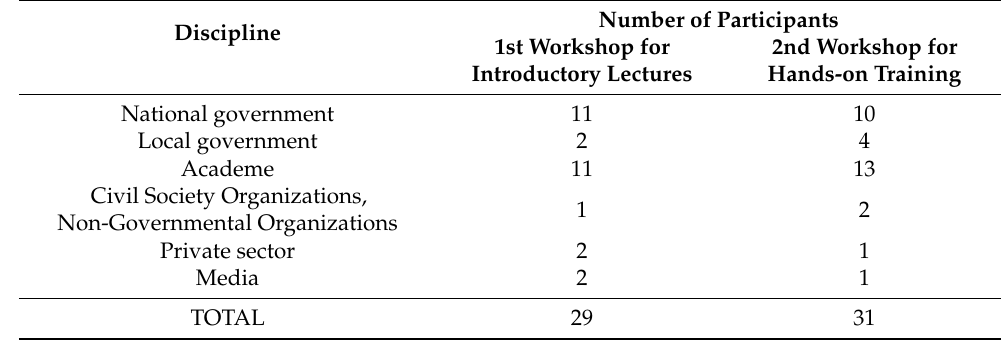
Table 3. Disciplines of Facilitators who have participated in the e-learning